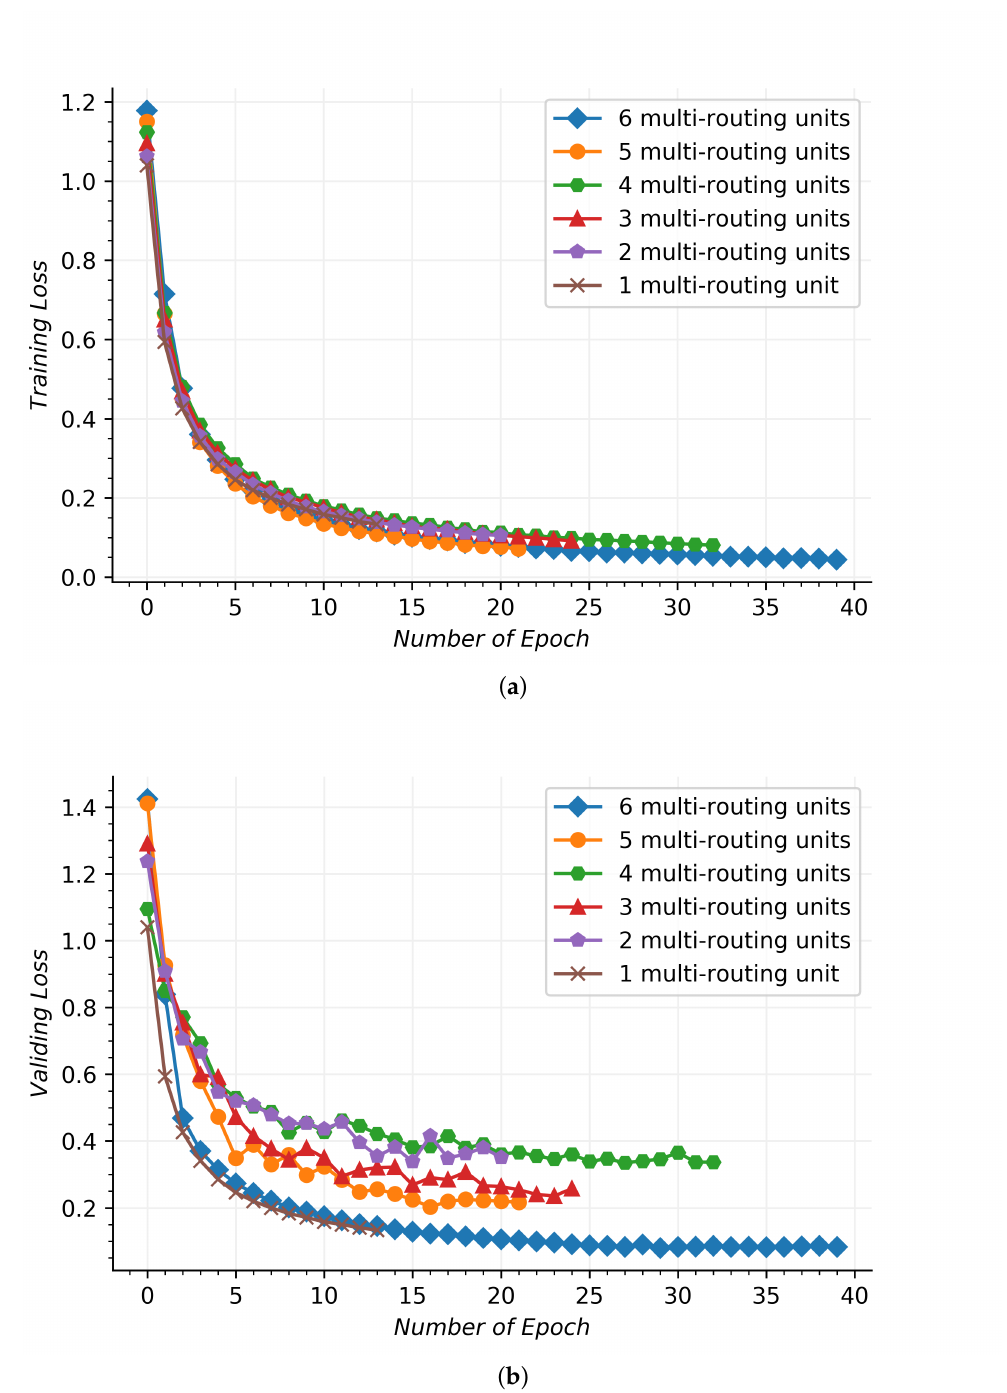
Figure 8. Training and validating process in the hybrid route network. ( a ) Training process. ( b ) Vali- dating